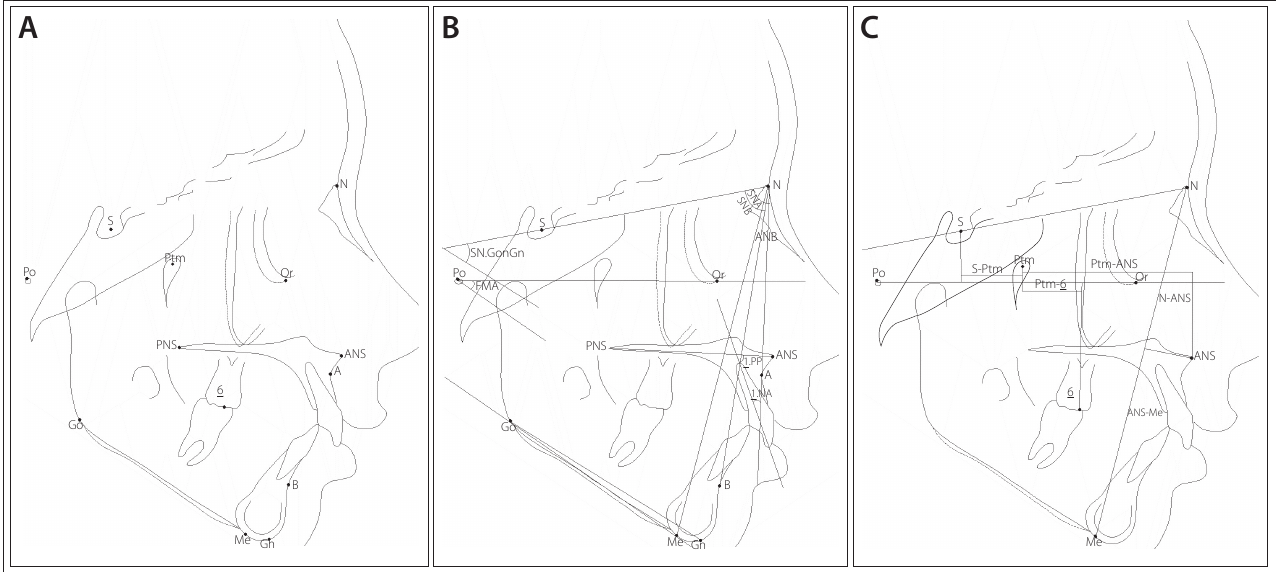
Figure 4. Cephalometric tracing of the initial treatment. ( A ) points utilized – Sella (S) is the center of the pituitary fossa; Nasion (N) is the junction of the frontonasal suture; Orbitale (Or) is the lowest point in the inferior margin of the orbit; Porion (Po) is the most superior point of the external auditory meatus; Pterygomaxillary fissure (Ptm) is the center point of the pterygomaxillary fissure; anterior nasal spine (ANS) is the tip of the bony anterior nasal spine; posterior nasal spine (PNS) is the dorsal limit of the maxilla; A point (A) is the point at the deepest midline concavity on the maxilla; 6 is the middle molar point; B point (B) is the point at the deepest midline concavity on the mandibular symphysis; Gonion (Go) is the point of intersection of the ramus plane and the mandibular plane; Menton (Me); Gnation (Gn) this is the most anteroinferior point on the symphysis of the chin; ( B ) angular measurements – SNA is the position of maxilla to cranial base; SNB is the position of mandible to cranial base; ANB is the skeletal anteroposterior jaw relationship, SN.GoGn is the skeletal pattern; FMA is the skeletal pattern; 1.NA is the axial inclinations of the upper central incisors to NA line; 1.PP is the axial inclinations of the upper central incisors to palatal plane. ( C ) linear measurements – S-Ptm is the anteroposterior position of the maxillary jaw; Ptm- ANS is the maxillary length; N-ANS is the anterosuperior facial height; ANS-Me is the anteroinferior facial height; Ptm-6 is the anteroposterior position of the upper